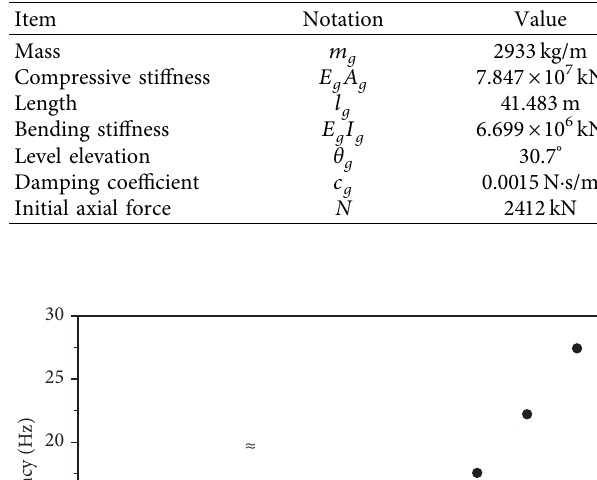
Table 2: Properties of the arch and load.